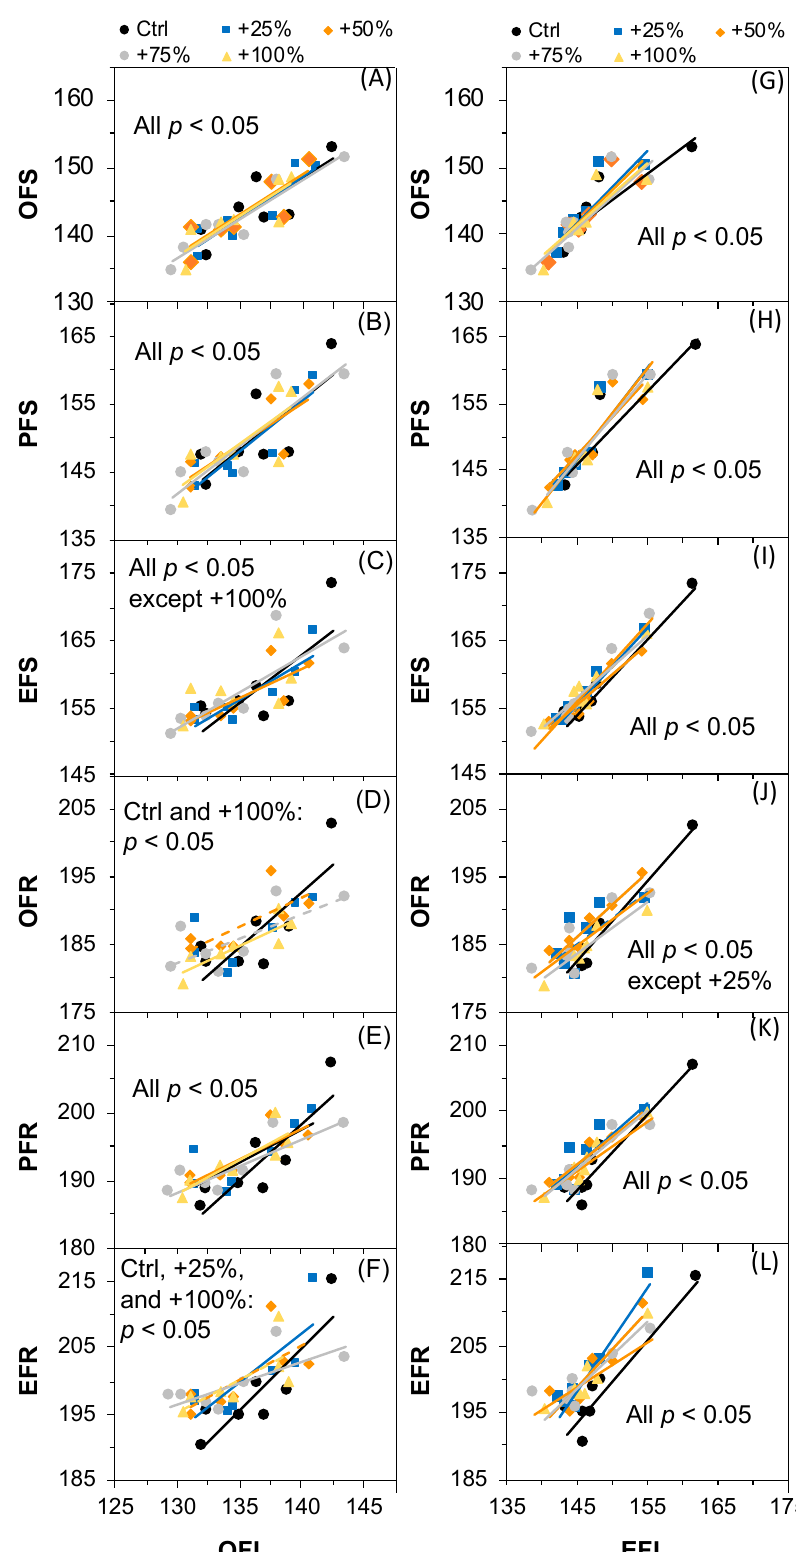
Figure 8. Correlations between the fruiting events and flowering events of Nitraria tangutorum . Correlations between OFL and OFS ( A ), PFS ( B ), EFS ( C ), OFR ( D ), PFR ( E ), EFR ( F ); and between EFL and OFS ( G ), PFS ( H ), EFS ( I ), OFR ( J ), PFR ( K ), EFR ( L ). The solid lines indicate p ≤ 0.05. The dashed lines indicate 0.05 ≤ p ≤ 0.1.